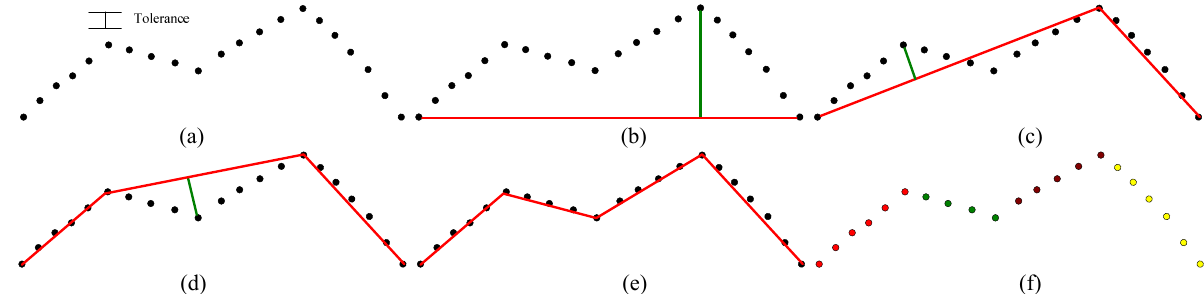
Figure 1: The basic Douglas-Peucker algorithm used in scan line